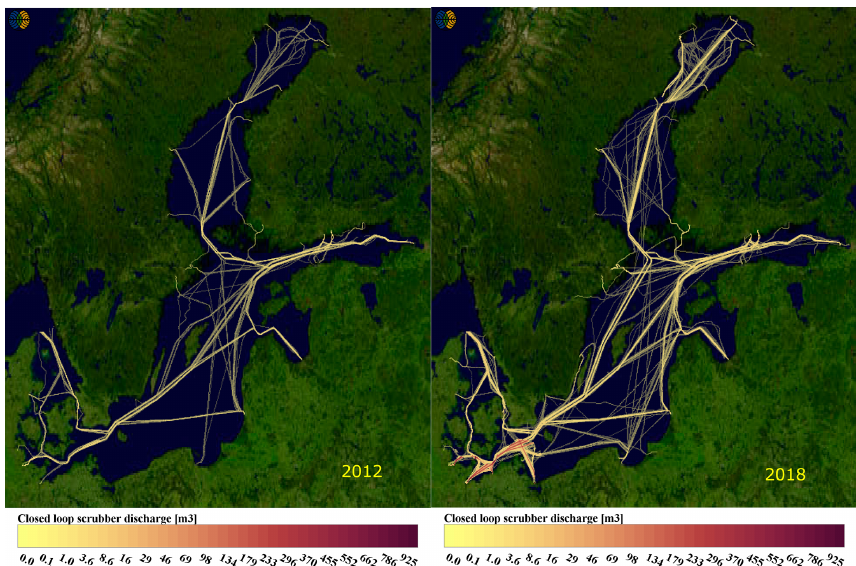
Figure 6. Discharge of scrubber effluent from closed-loop systems during 2012 (left) and 2018 (right). The values for discharges are reported in units of cubic metres for each map grid cell of 5km 2 . Map: background Landsat-8 image courtesy of the US Geological